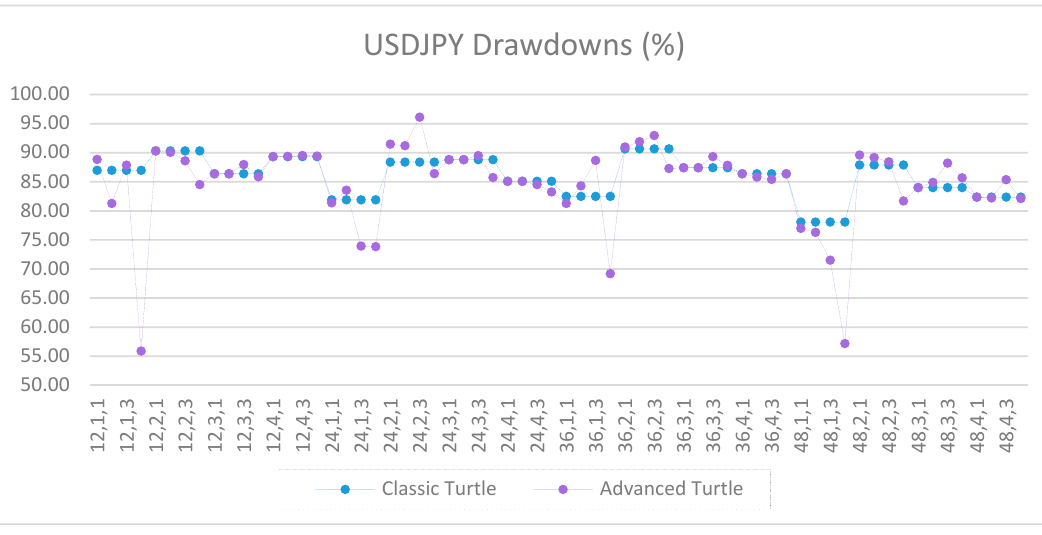
Figure A42. Drawdowns of USDJPY as percentage of equity between the classic and the advanced Turtle systems for every combination of N, X, Y for the slow parameters (80, 160).